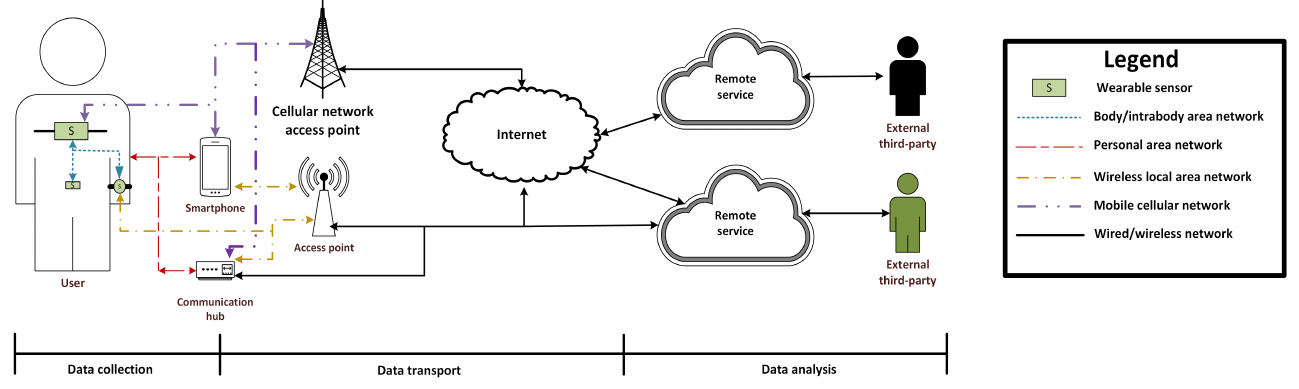
Figure 7. General architecture of wearable sensing